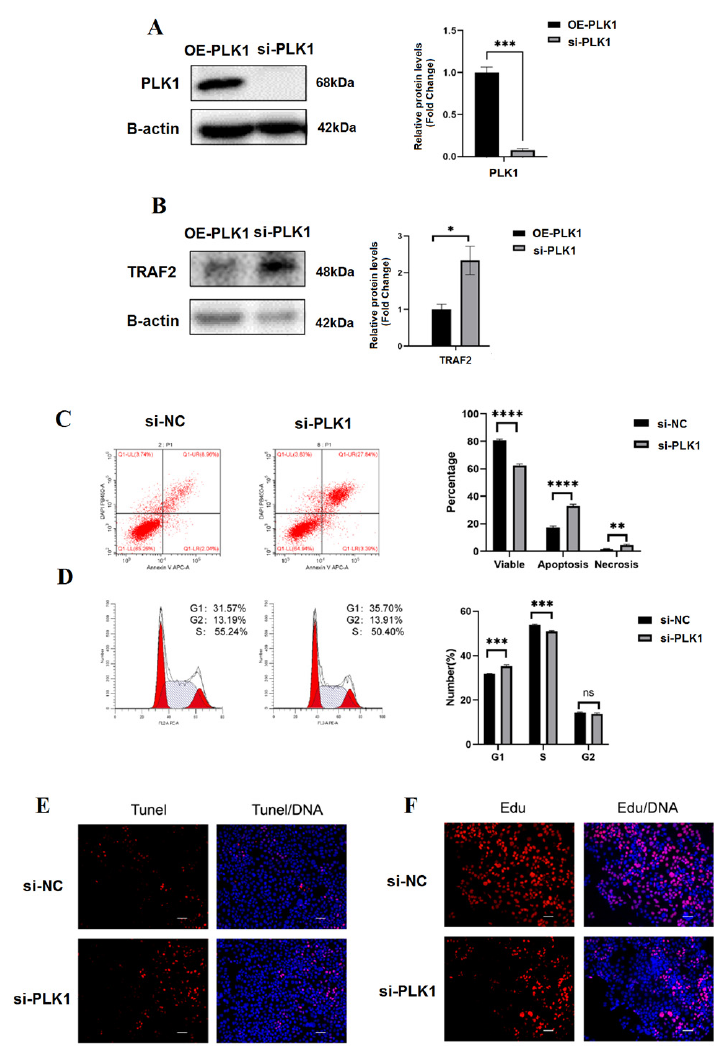
Figure 3. PLK1 knockdown arrests the cell cycle and suppresses proliferation and trophoblasts apoptosis: ( A ) PLK1 expression was examined following transfection of particular si-RNA and OE-PLK1; ( B ) WB analysis was utilized to detect how PLK1 knockdown affected the amount of